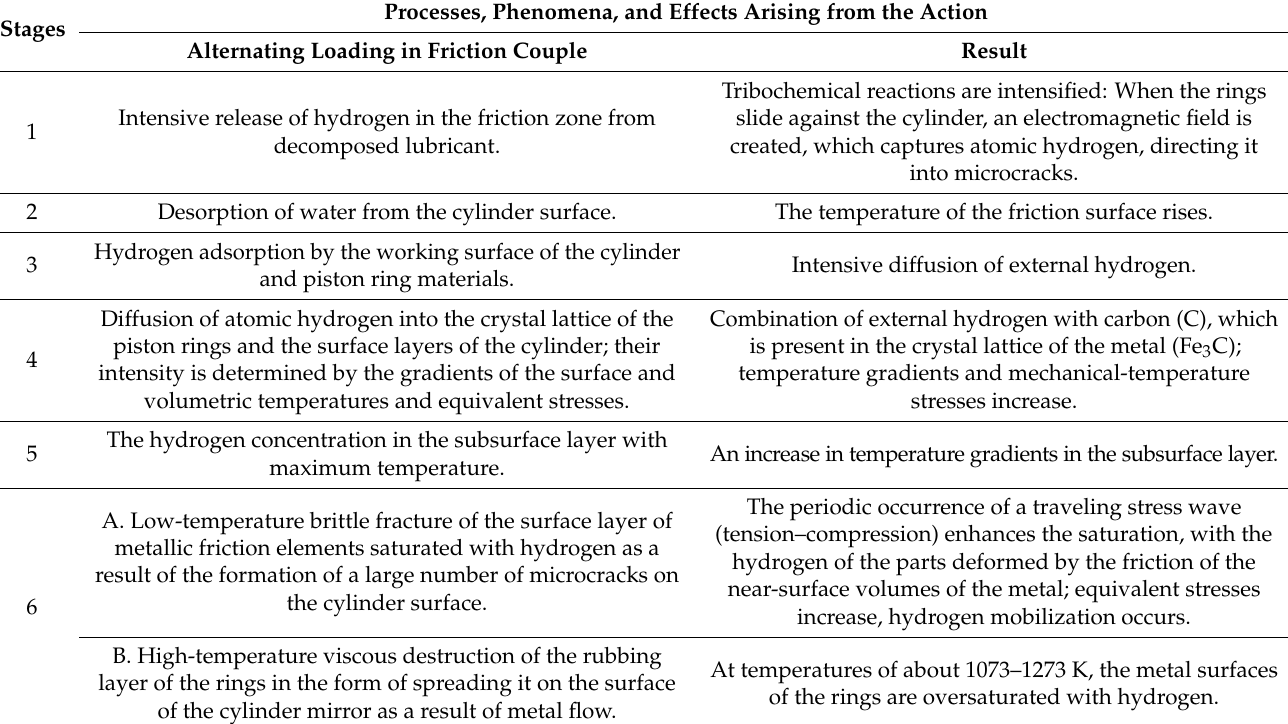
Table 2. Stages of hydrogen wear of the friction pair “ring–cylinder mirror” working surfaces during electrothermomechan- ical